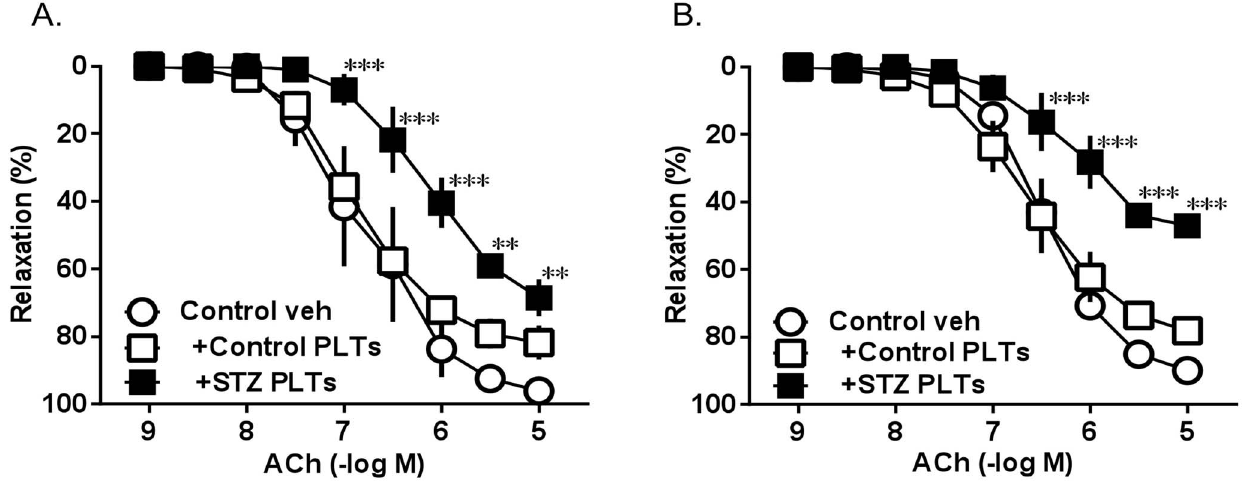
Figure 1. ACh-induced vasorelaxation of carotid arterial rings from controls induced for 30 min with PLTs isolated from control (Control PLTs) and diabetic (STZ PLTs) rats. (A) 36-weeks old. (B) 52-weesks old. Carotid arterial rings were preincubated with each type of PLT (1.65 6 10 7 cells/mL + 30 min). Data are means 6 SE; n=4; ** P , 0.01, *** P , 0.001 vs. control. doi:10.1371/journal.pone.0102310.g001 PLOS ONE |